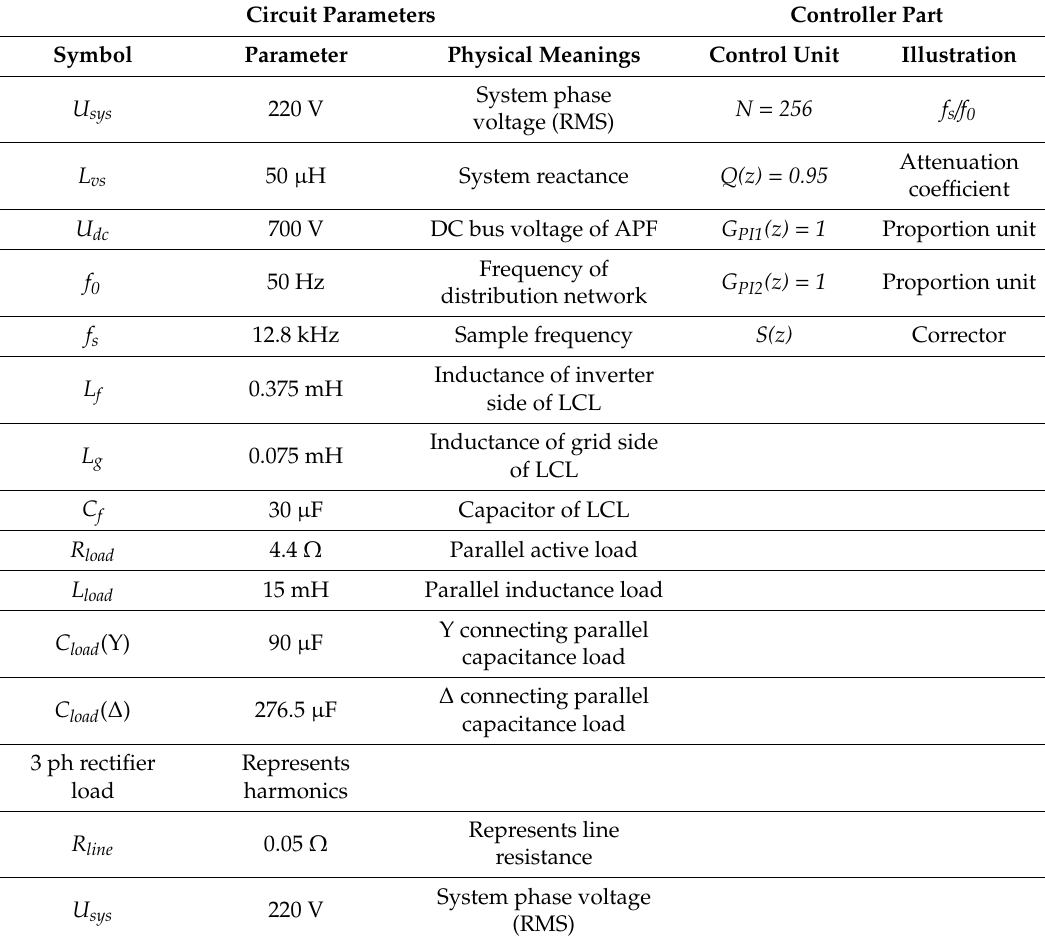
Table 1. Parameters of shunt active power